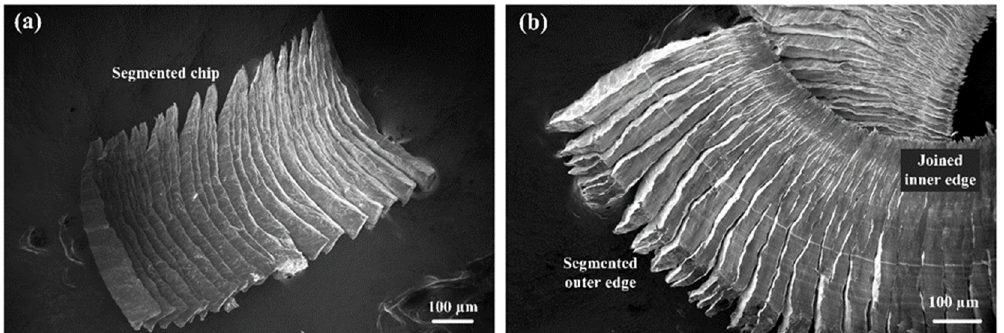
Figure 8. Chip morphologies during machining of the RZ5/8 wt.% TiB 2 composite at cutting speeds of ( a ) 50 m/min and ( b ) 100 m/min .